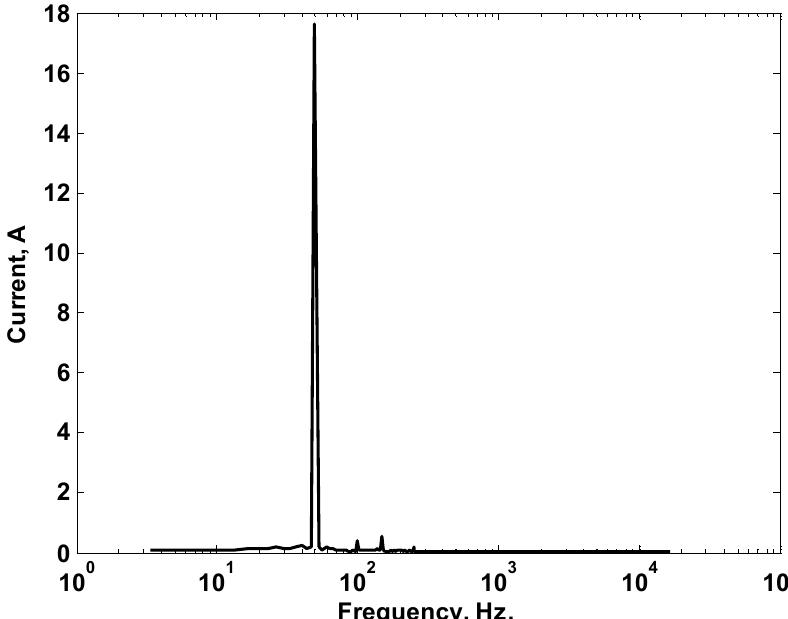
Figure 12. FFT of the Current Waveform Shown in Figure 10.